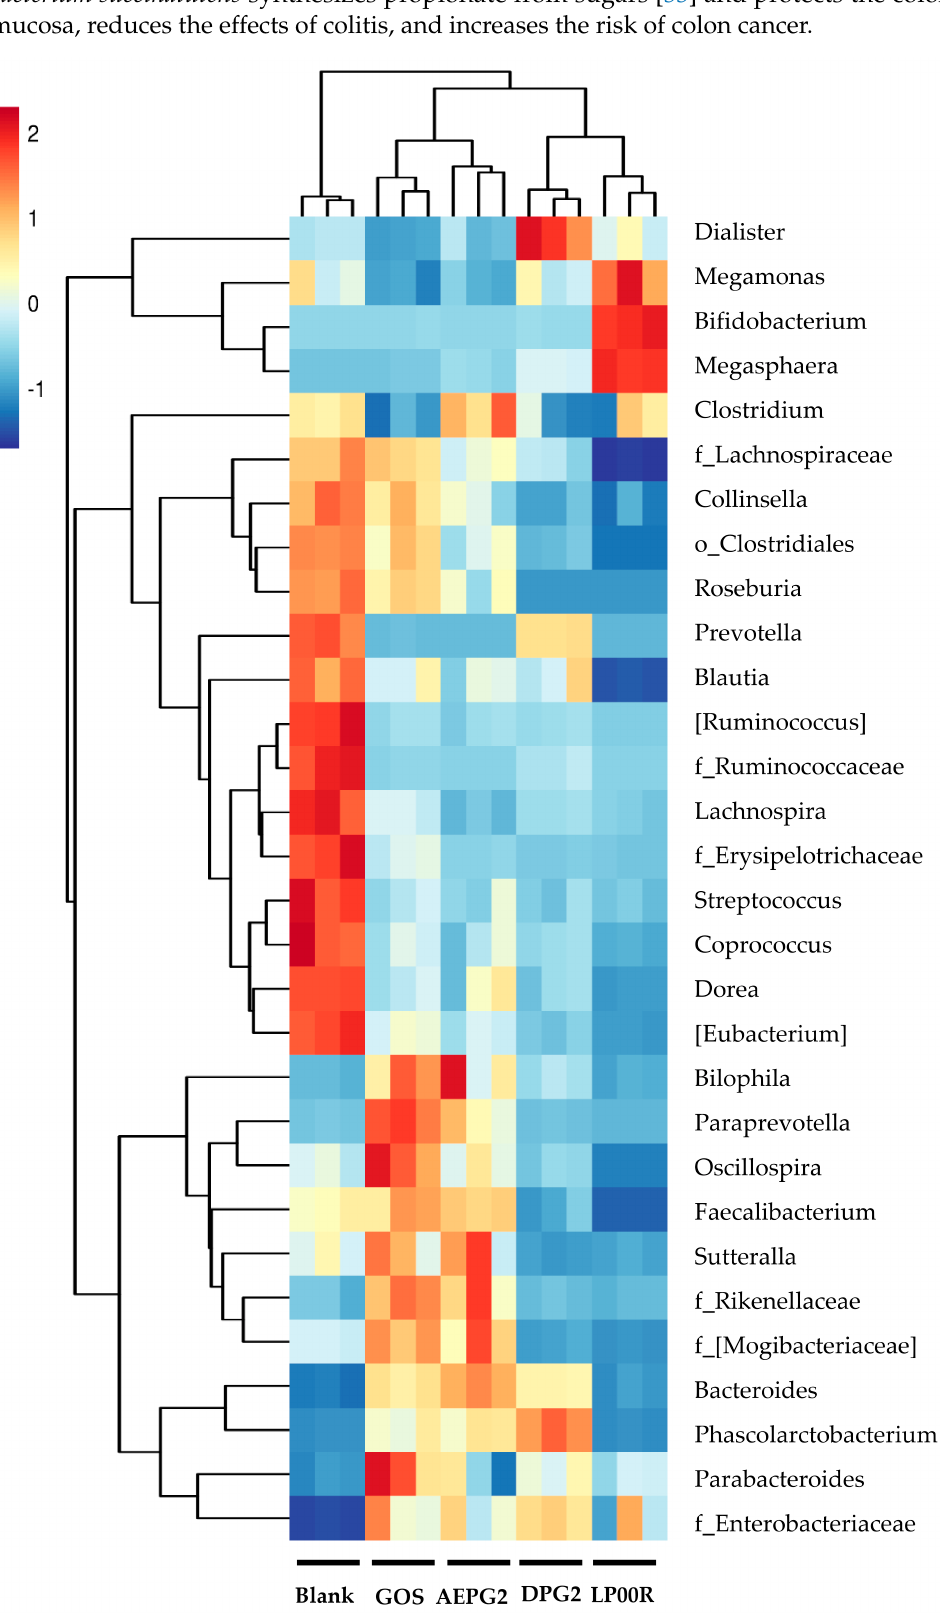
Figure 7. Heat map of gut microbial composition at the genus level. The main bacterial genus involved in the fermentation of PGPs was Bacteroides (the relative abundances were 37.82%, 45.83%, and 16.92% for the AEPG2, DPG2, and LP100R